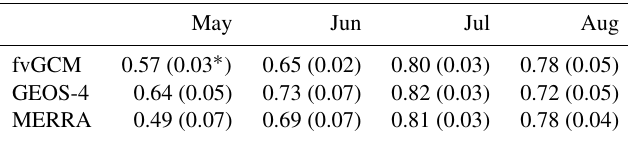
Table 1. Global lightning NO x emissions (TgNmon − 1 ) during May–August in the GMI CTM driven by three meteorological data sets (fvGCM, GEOS-4, and MERRA).